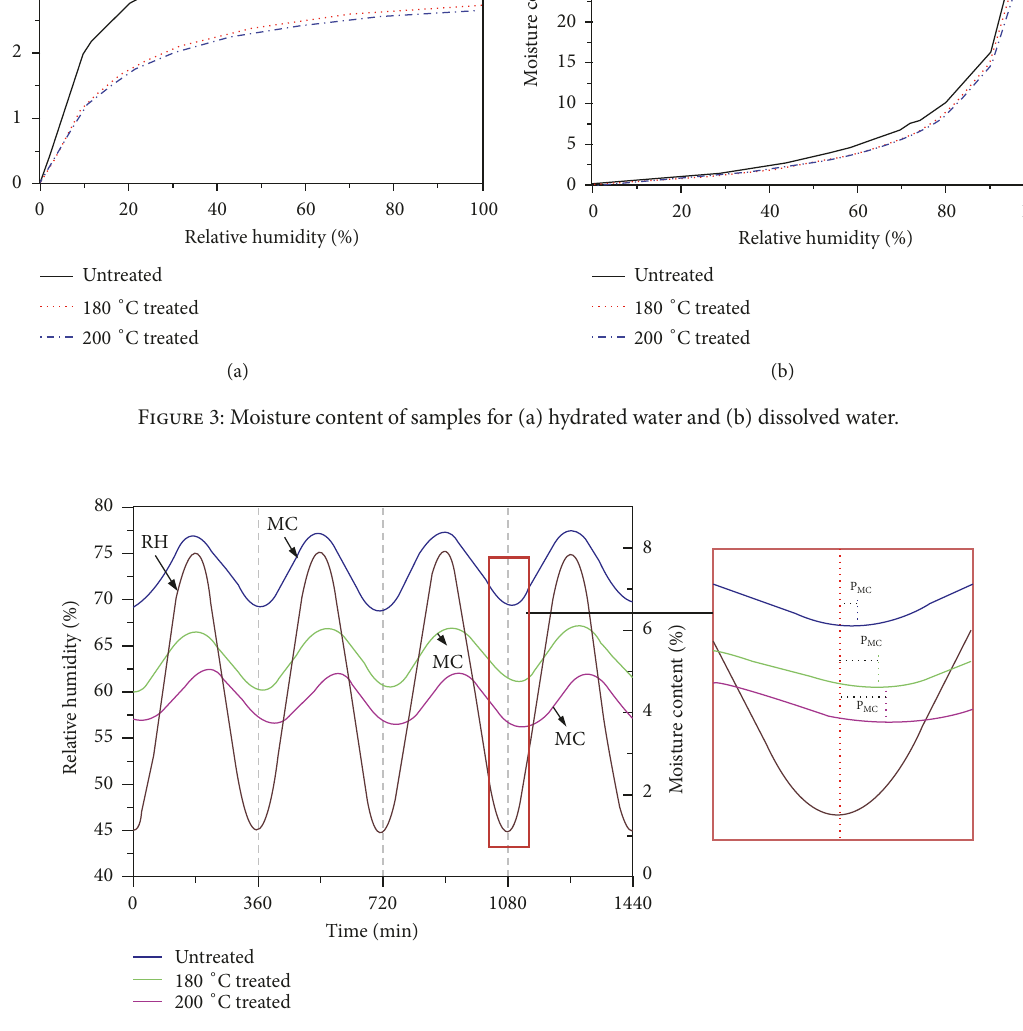
Figure 4: Plots of moisture content changes where relative humidity changes sinusoidally at a constant temperature against cyclic time for untreated and heat-treated bamboo samples. P MC : phase lag of MC